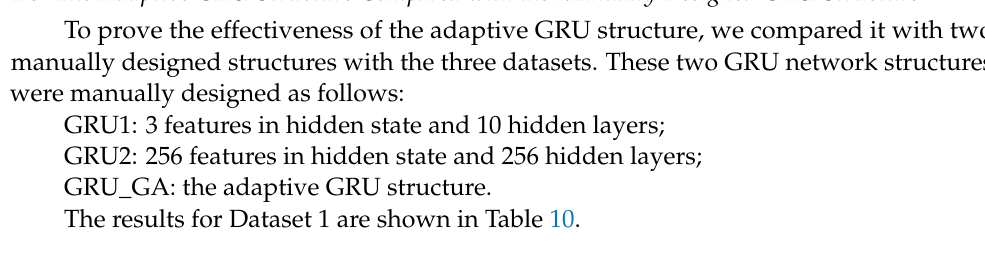
Table 9. The best fitness and corresponding network structure in Dataset 3. Generations